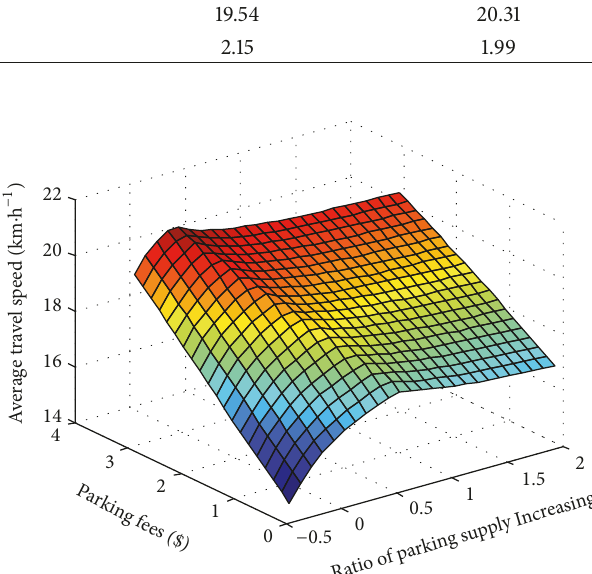
Figure 8: The relation between parking charge, parking supply, and travel